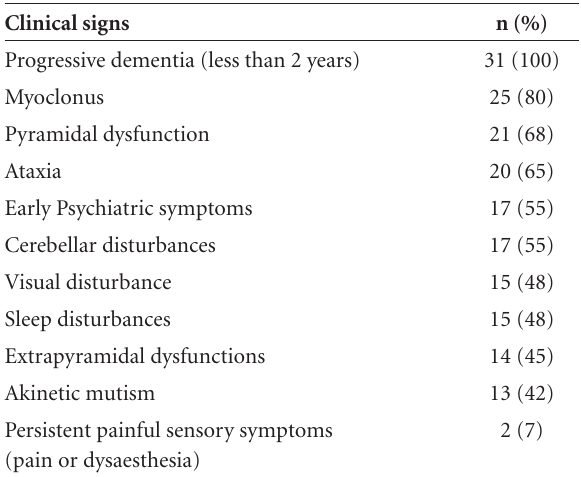
Table 2. Clinical signs presented in patients whose notification form was complete.